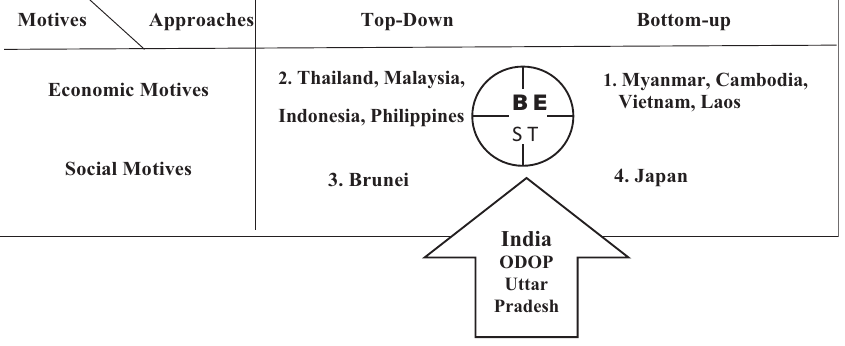
Figure 1. Matrix of Development Strategy for OVOP in ASEAN Vis- (cid:1)